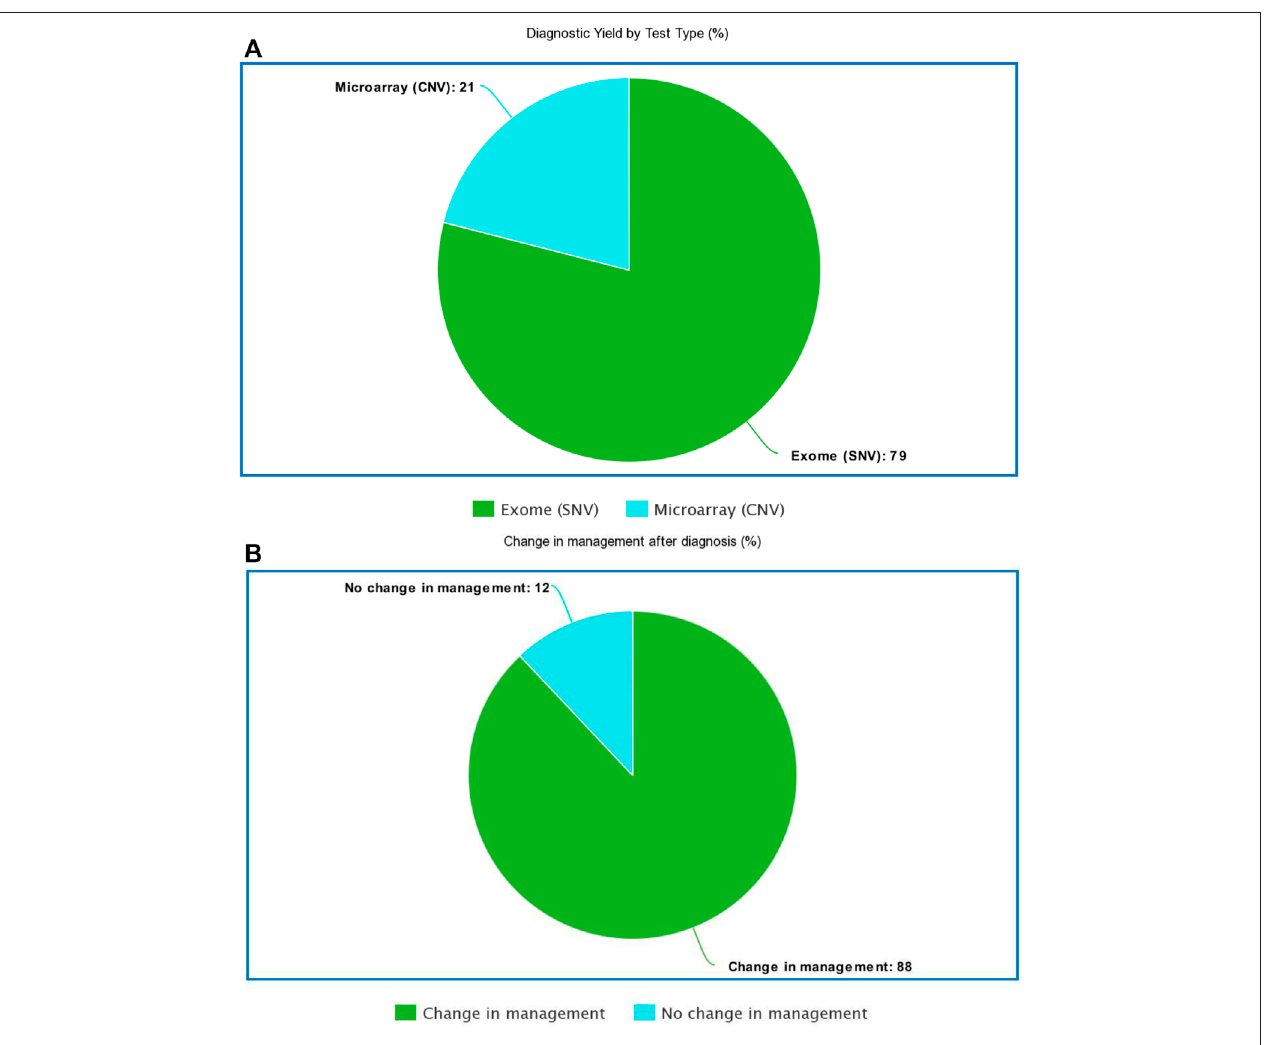
FIGURE 2 | (A) : Diagnostic yield by test type (B) : Percentage of the diagnosed cohort where disease speci fi c management changes were implemented.